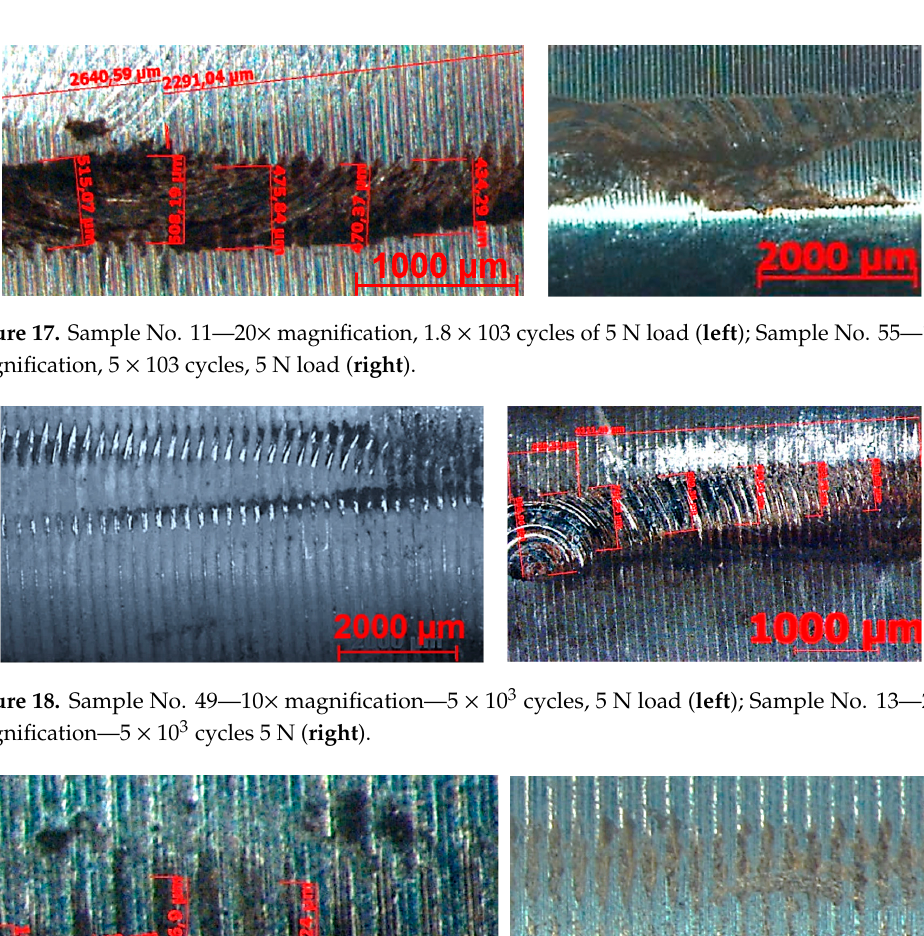
Figure 16. Graphs of all cylinders’ wears—measured on the tribometer.